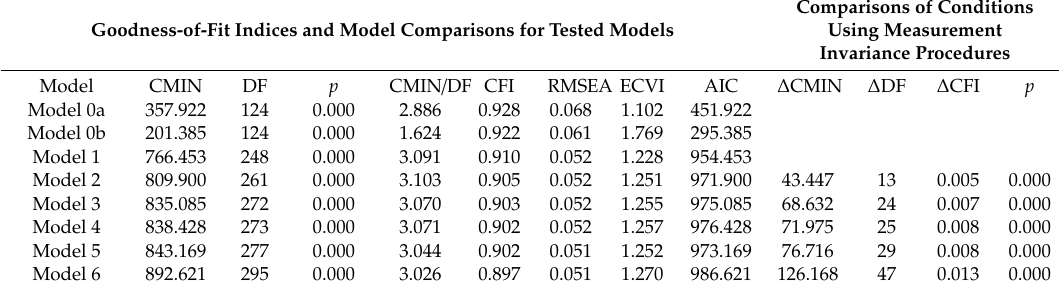
Comparisons of Conditions Using Measurement Invariance Procedures